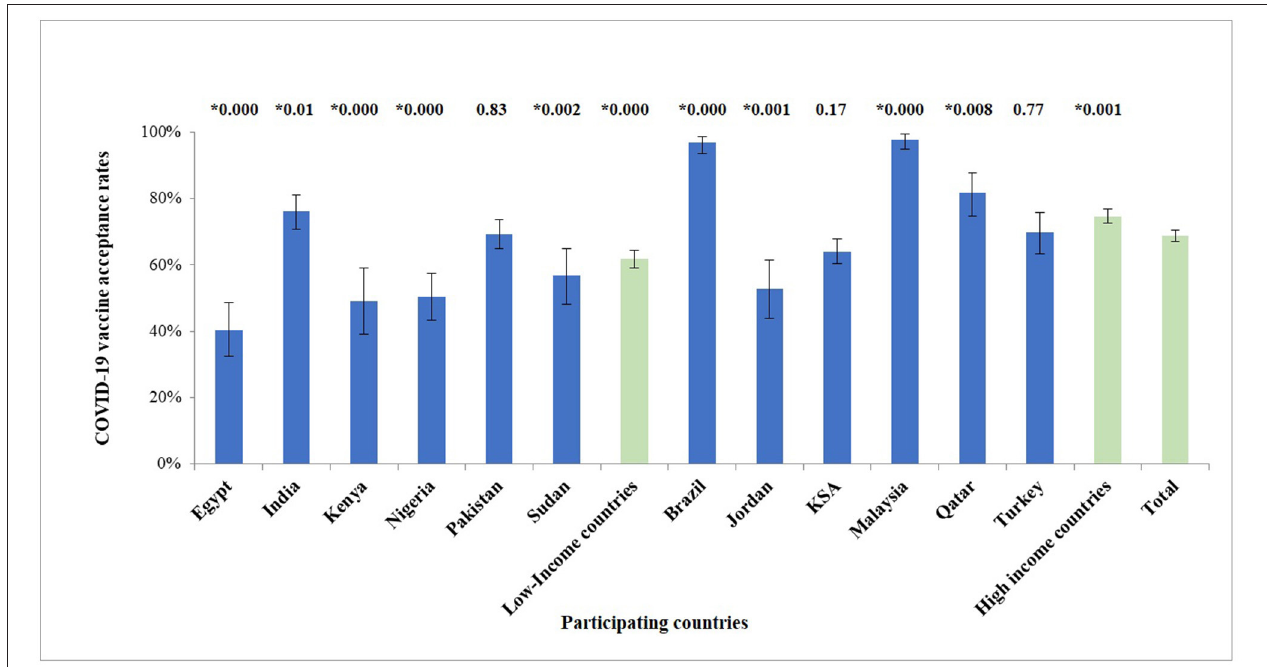
FIGURE 1 | Agreement to accept a COVID-19 vaccine (proportion ± 95% confidence interval) among HCWs in different countries. Numbers above each bar represent the p -value for the differences between the intention to vaccinate in each country compared to the total of all the countries (0.000 means p < 0.001). *Denotes significant difference ( p <